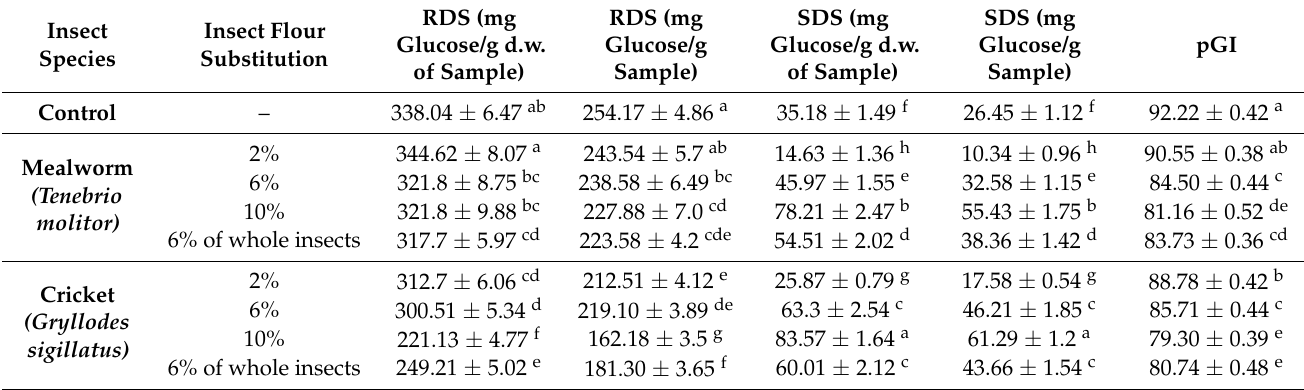
Table 8. Rapidly and slowly digestible starch contents and in vitro glycemic index values for